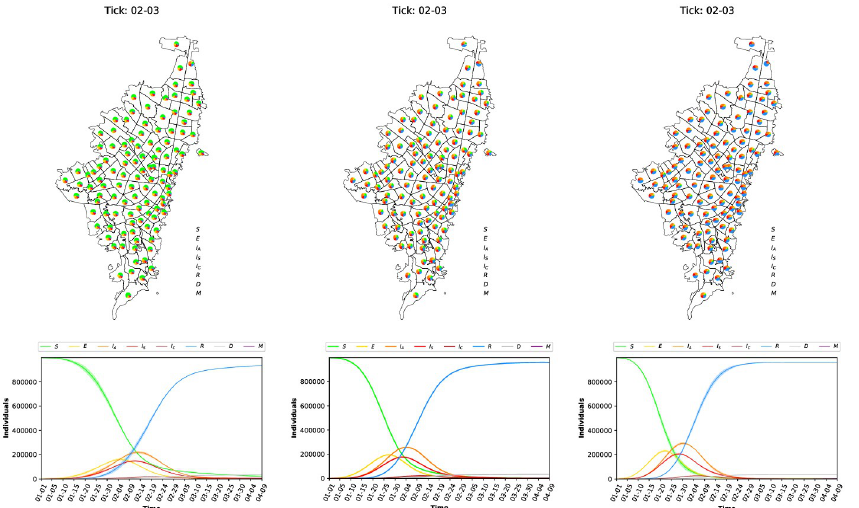
Fig 5. Sensitive analysis for the infection probability α . α = 0.09 (left), α = 0.18 (middle), α = 0.36 (right).